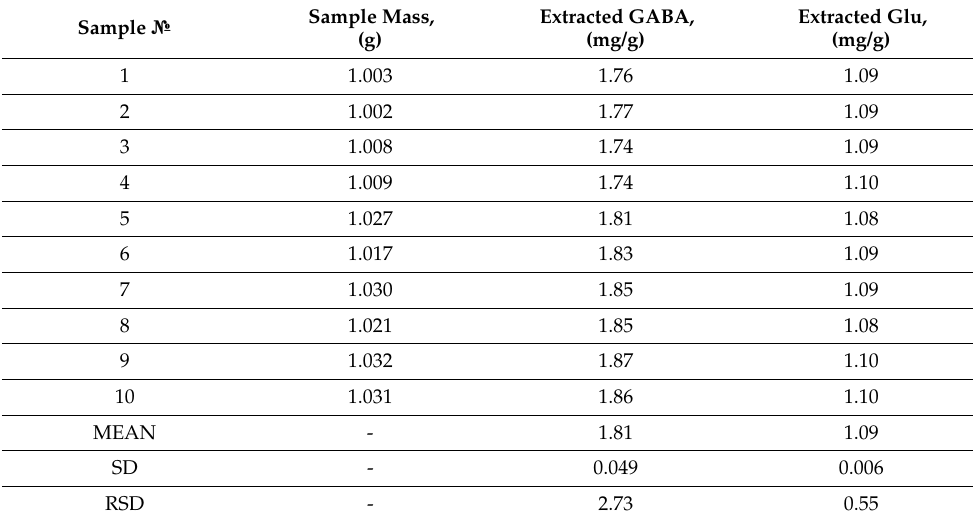
Table 3. Repeatability of GABA and Glu extraction ( n = 10).